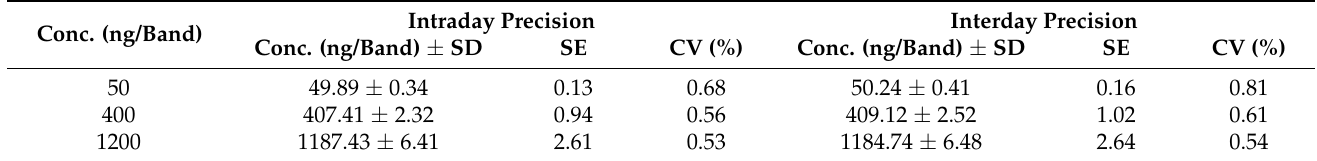
Table 4. Determination of the intra/inter-day precision of AA for the greener HPTLC method a .